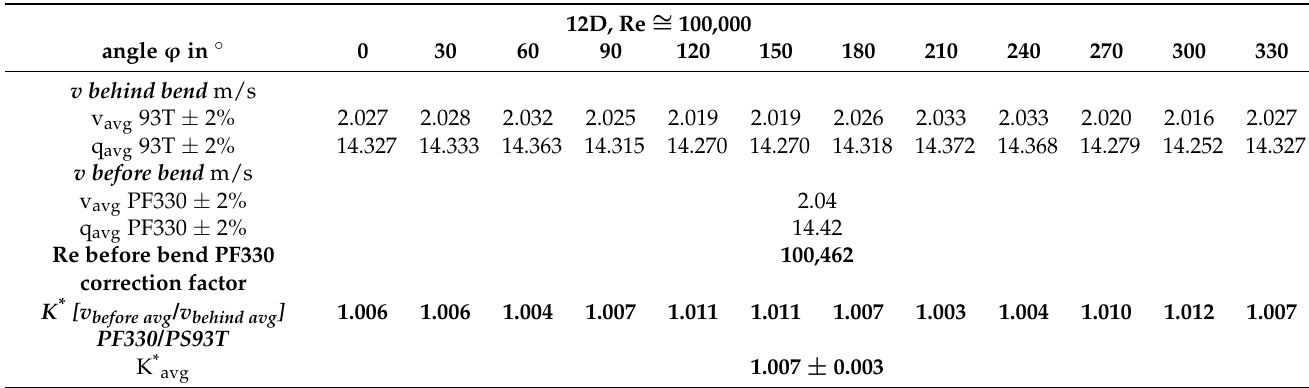
Table 10. Summary of the results of ultrasonic measurements for the 12D plane from the disturbing element as a function of the mounting angle of the ultrasonic flow meter heads, Re ∼ = 100,000. 12D, Re ∼ = 100,000